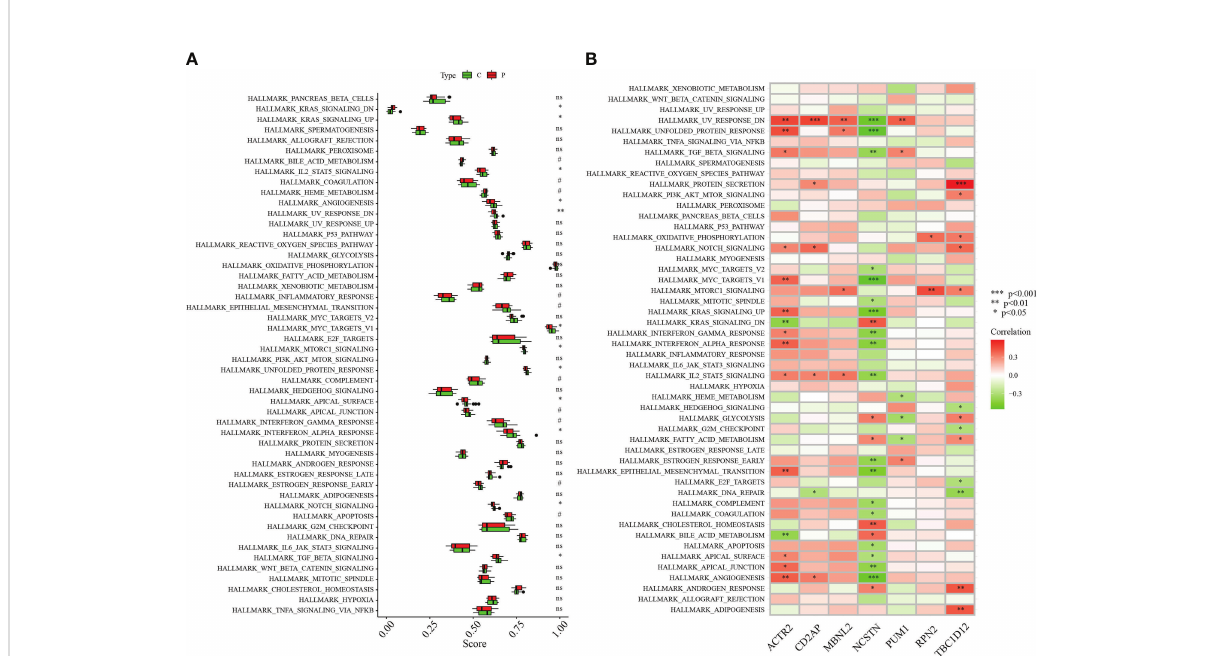
FIGURE 7 Correlation between hub genes and the 50 HALLMARK signaling pathways. (A) Comparison of the 50 HALLMARK signaling pathways between the RA group and healthy controls. (B) Correlation between the target genes and the 50 HALLMARK signaling pathways. *p < 0.05, **p < 0.01, ***p < 0.001 0.05. 0.05 < p < 0.2. NS, no signi fi cance.